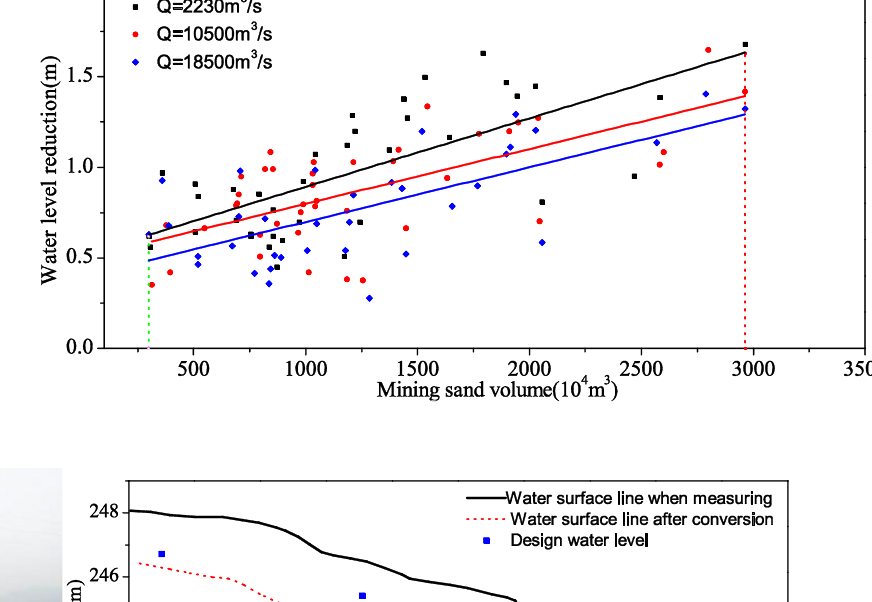
Fig. 24 The relationship between the amount of sand extracted and the water level reduction every 50 km